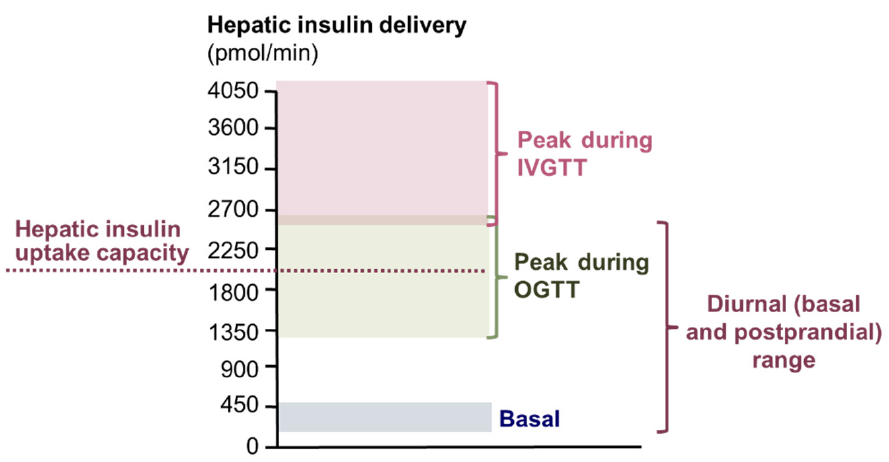
Figure 4. Hepatic insulin delivery during basal and postprandial conditions and during intravenous and oral glucose tolerance tests. Hepatic insulin delivery rates were calculated as described in reference [18] with average insulin secretion and plasma insulin concentration values reported in the literature. See text for details. Abbreviations: IVGTT, intravenous glucose tolerance test; OGTT, oral glucose tolerance test.